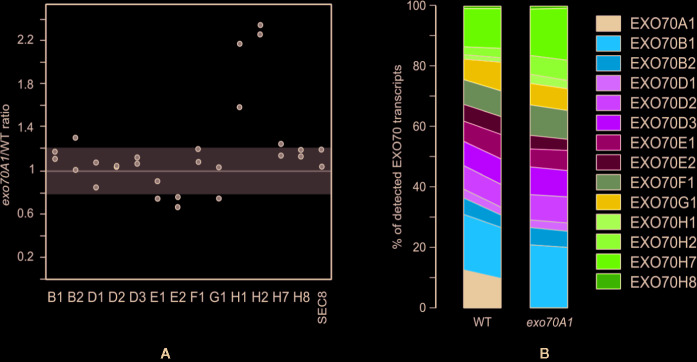

(A) Relative transcript levels of detectable EXO70 isoforms and the SEC8 subunit in exo70A1 mutant vs. WT seedlings (from two replicates). Gray zone represents a less than 20% change in transcript abundance. (B) Composition of the EXO70 transcript population in exo70A1 mutant vs. WT seedlings. Two replicates for each genotype are represented by the left and right sides of the corresponding stacked bar graph, respectively. For gene terminology see
Figure 1
.